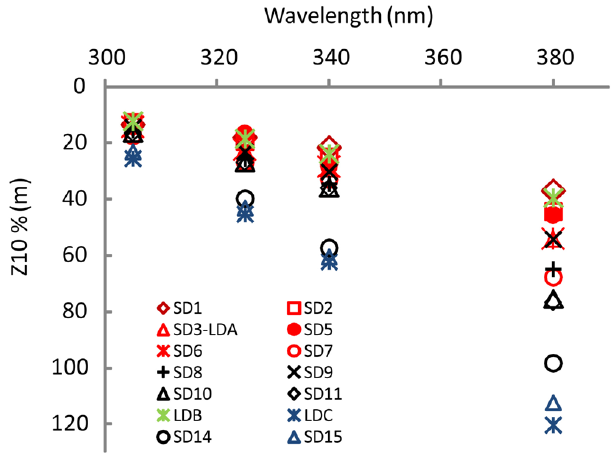
Figure 3. OUTPACE AOPs (continued). Z 10% (λ) at 305nm (UV- B), and 325, 340 and 380nm (UV-A) at all stations during OUT- PACE in the western tropical South Pacific with color code de- pending on TChl a (in red: high concentrations (0 . 185 < TChl a < 0 . 35mgm − 3 ; SD1 to SD7, Melanesian archipelago), in black: me- dian concentrations (0 . 06 < TChl a < 0 . 1mgm − 3 ; SD8 to SD11 around the islands of Fiji), in blue: low concentrations (TChl a < 0 . 11mgm − 3 ; SD14 to SD15 including LDC) with the frontal station LDB in green (Table